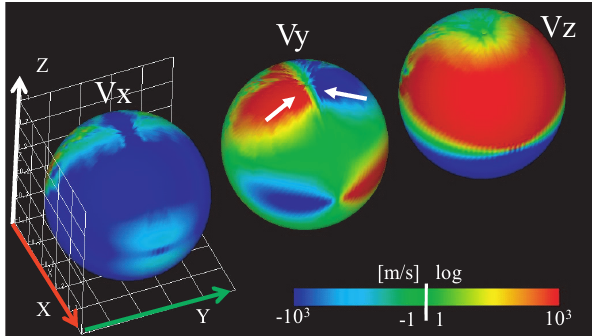
Fig. 7. The velocity components at the altitude of 400km in the dayside ionosphere. From left to right, V X , V Y and V Z